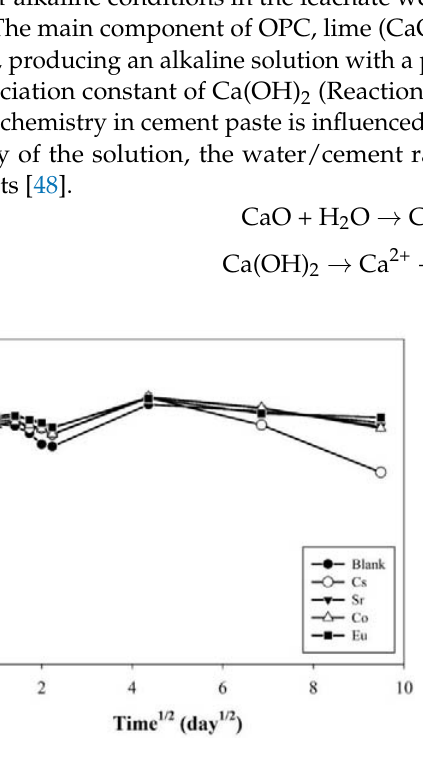
Figure 2. Leachate pH from the cement specimens up to 90 days of testing.